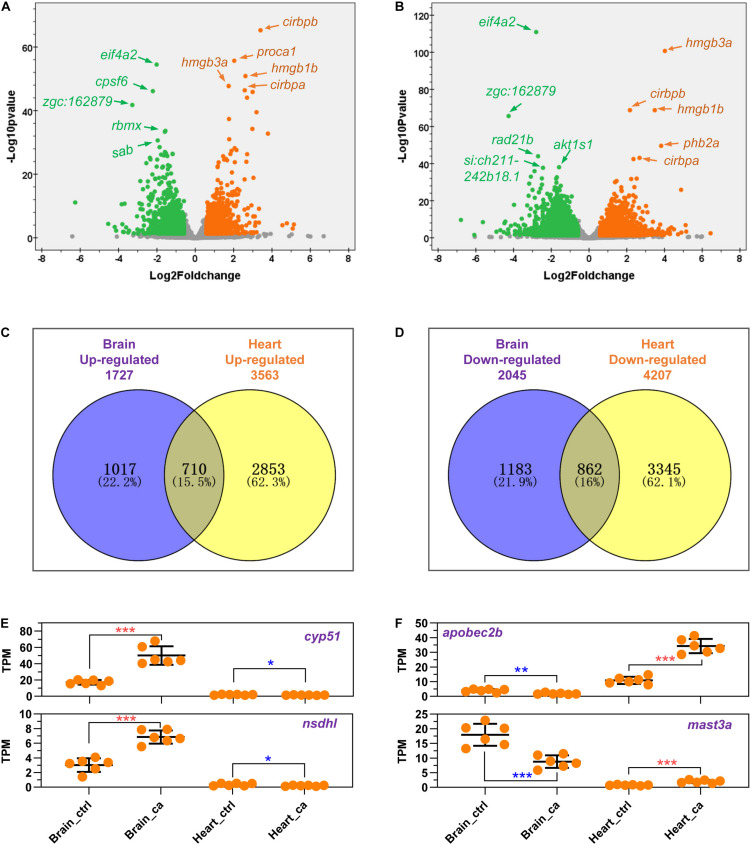
Cold-regulated gene expression in the brain and the heart of common carp. (A,B) Volcano plots indicate the up- and down-regulated genes in the brain (A) and the heart (B). The top up- and down-regulated genes are shown in yellow and green, respectively. (C,D) Venn plots indicate numbers of the common and tissue-specific up- (C) and down-regulated (D) genes in the brain and the heart. (E) Genes up-regulated in the brain and down-regulated in the heart. (F) Genes up-regulated in the heart and down-regulated in the brain. Individual cases are displayed, the mean and SD of data sets are indicated (n = 6). The means of gene abundance for different treatments were compared by Independent Sample T-test; *p < 0.05; **p < 0.01; ***p < 0.001.